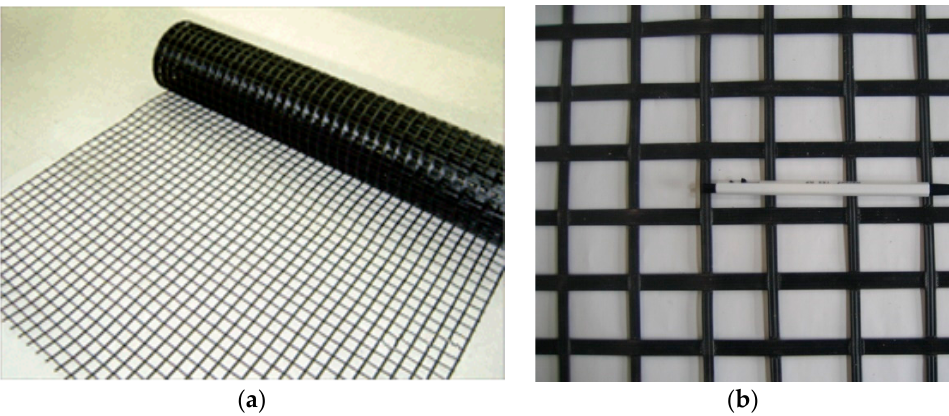
Figure 3. (a) Shape of geogrid reinforcement used for pullout test ( b ) close-up of geogrid.